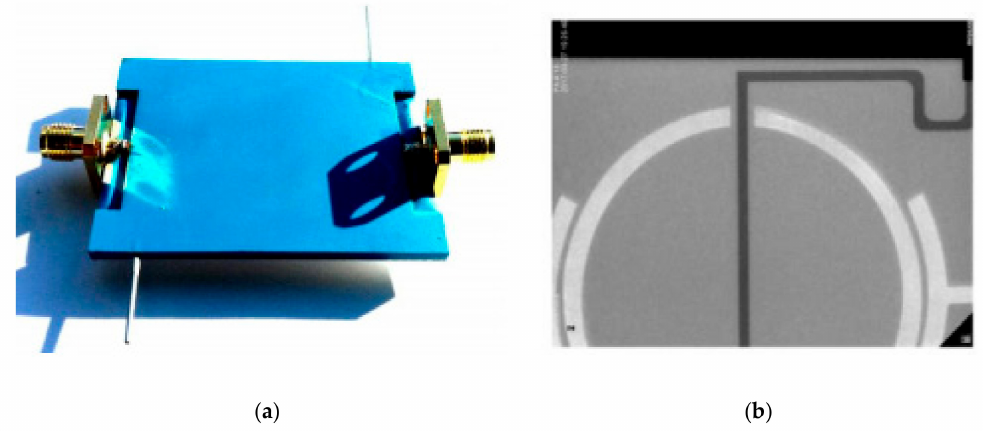
Figure 16. The photo of the manufactured detector ( a ) and the X-ray image with the microwave circuit of the detector ( b ) [101].